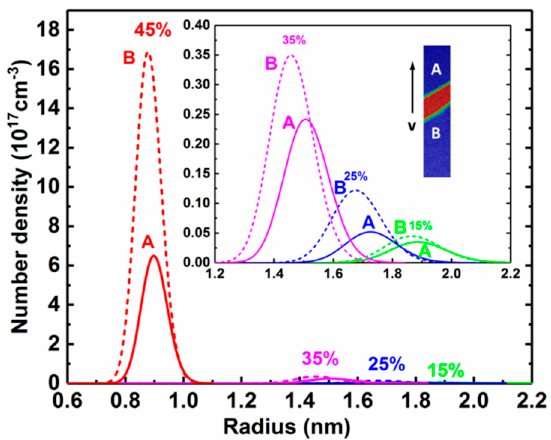
Figure 6. Mn-C SRO in location A (before the PLC band passes through) and B (after the PLC band passed through) in deformed samples with strains of 15–45%.